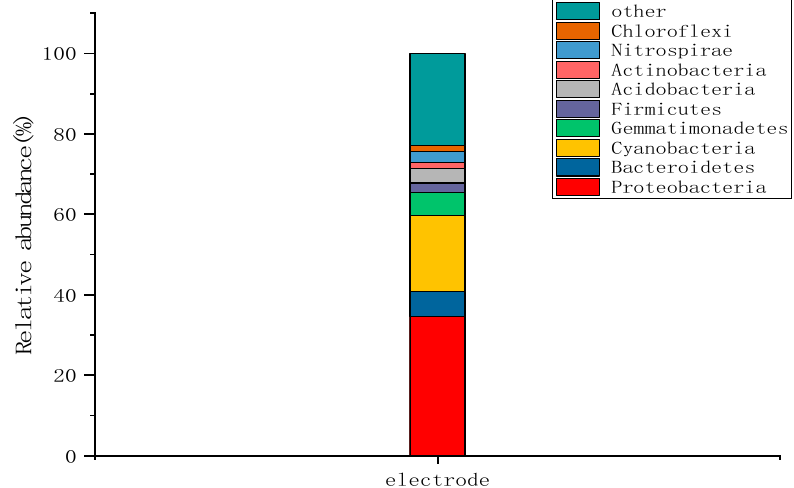
Figure 7. Microbial group level changes at the wetland electrode.